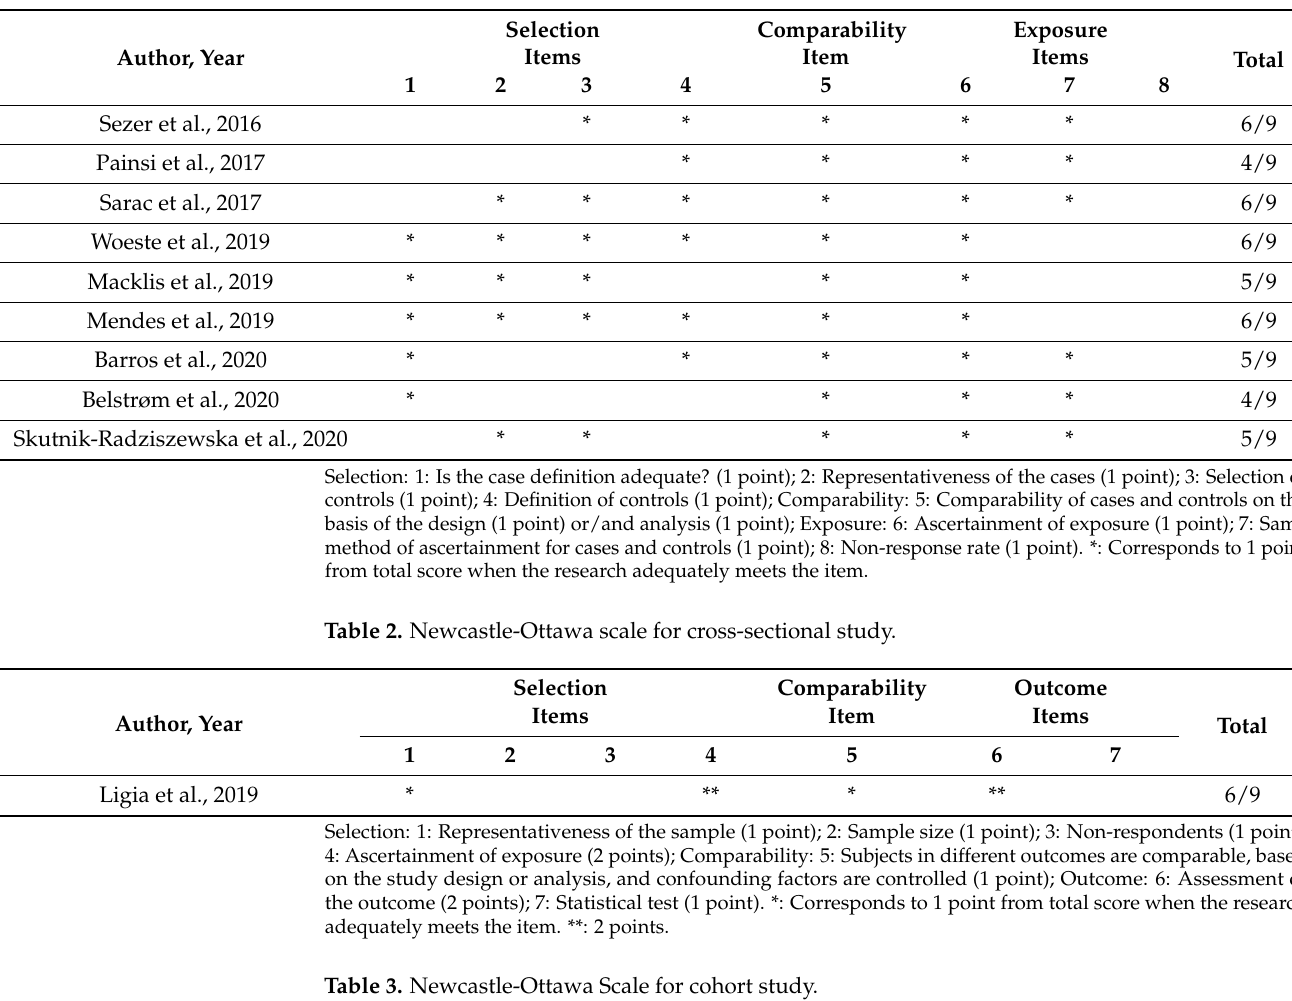
Table 1. Newcastle–Ottawa scale for case–control study.